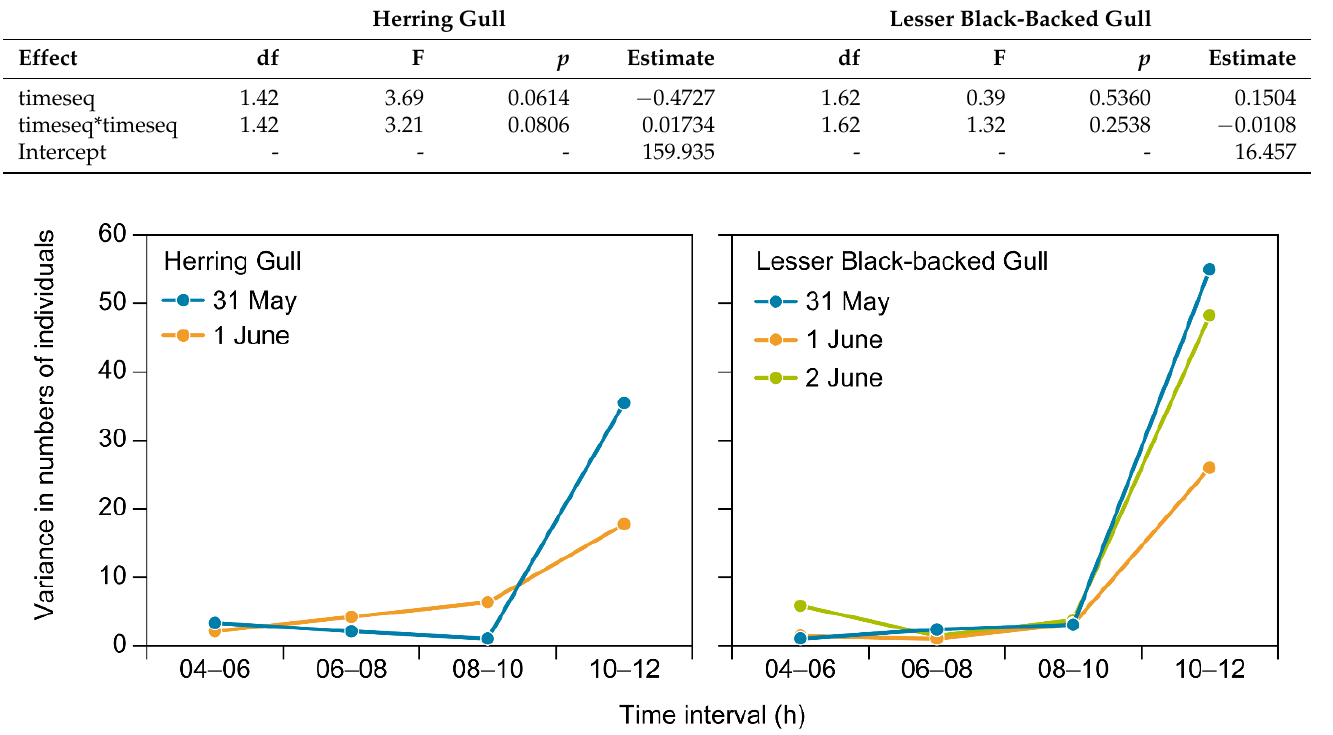
Table 3. Outputs from the test of changes in numbers of birds present in the two colony plots during the first part of the day. Date was included as a random effect and the model corrected for a first-order autocorrelation. Photos of the two plots were taken by the wildlife cameras at 20 min intervals.